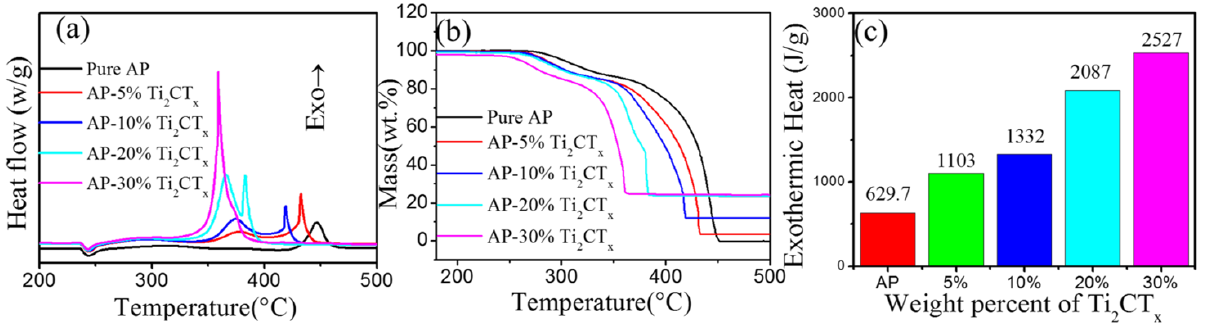
Figure 2. ( a ) DSC, ( b ) TG curves, and ( c ) heat release of pure AP and AP- x wt.%Ti 2 CT ( x = 5, 10, 20, 30 wt.%). Table 1. Comparison of catalytic activity for AP by MXenes and their